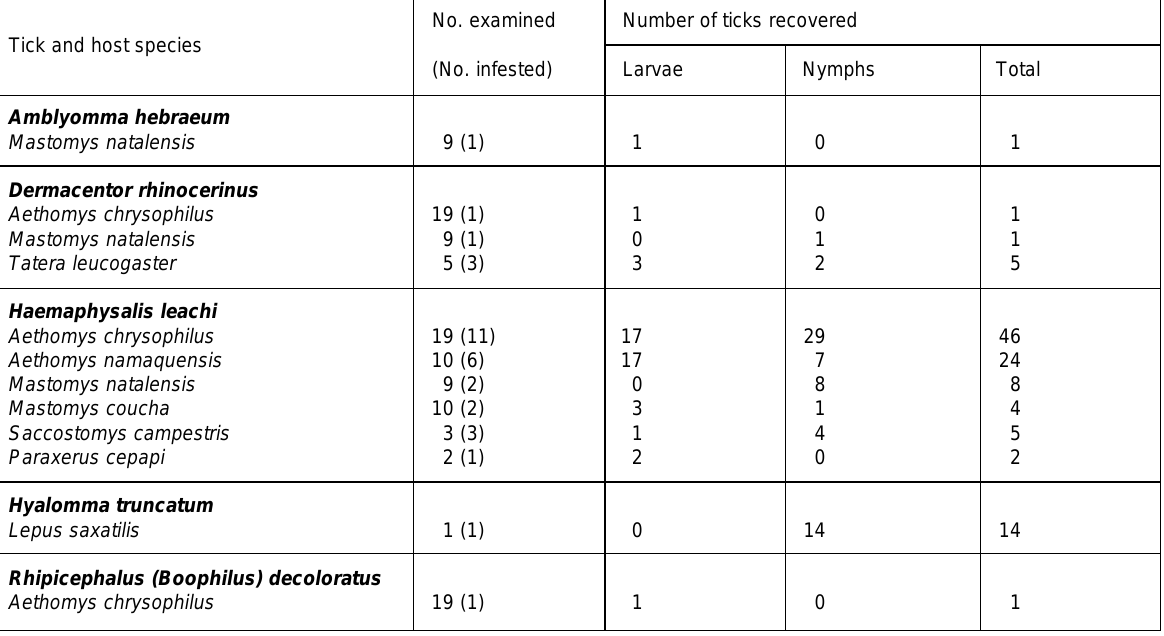
TABLE 4 Ticks, other than Rhipicephalus species, on small mammals in north-eastern Mpumalanga and Limpopo Provinces No. examined Number of ticks recovered Tick and host species (No. infested) Larvae Nymphs Total